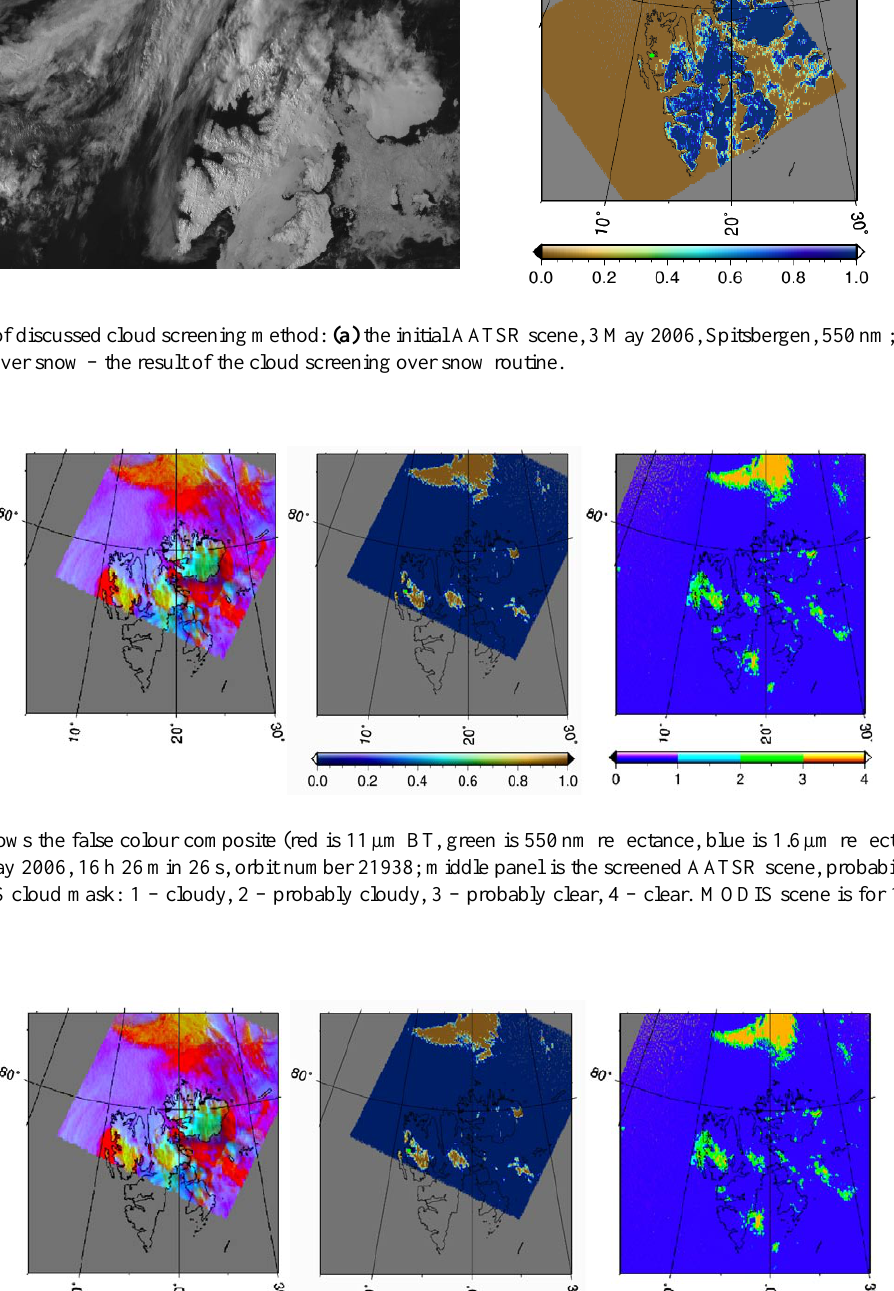
Figure 6. Left panel shows the false color composite (red is 11µm BT, green is 550nm 2 Fig. 7. Left panel shows the false colour composite (red is 11µm BT, green is 550nm reflectance, blue is 1.6µm reflectance) of the AATSR scene, 8 May 2006, 13h 2min 12s, orbit number 21893; middle panel is the screened AATSR scene, probability of clean snow; right panel reflectance, blue is 1.6 µm reflectance) of the initial AATSR scene, 11 May 2006, 16 h 26'26'', 3 is MODIS cloud mask: 1 – cloudy, 2 – probably cloudy, 3 – probably clear, 4 – clear. MODIS scene is for 8 May 2006, 12h orbit number 21938; middle panel is the screened AATSR scene, probability of clean snow; 4 right panel is MODIS cloud mask: 1 – cloudy, 2 – probably cloudy, 3 – probably clear, 4 - 5 clear. MODIS scene is for 11.05.2006, 16 h 40'. 6